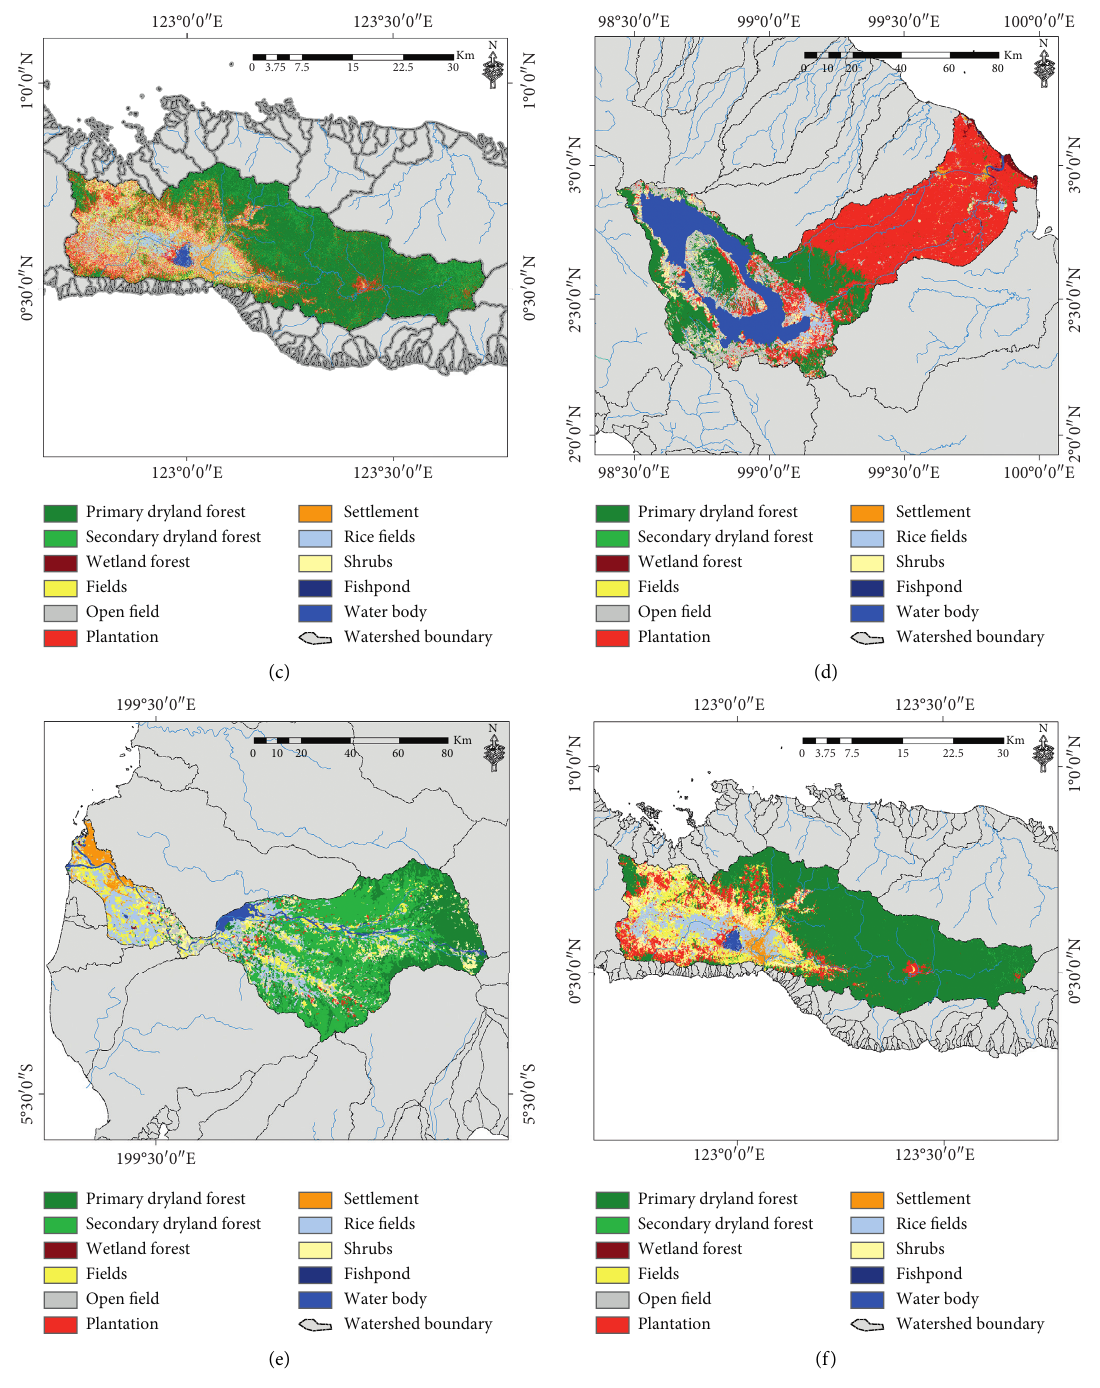
Figure 8: Results of the LULC classification based on the RF classifier: (a, d) Asahan Toba watershed; (b, e) Jeneberang watershed; (c, f) Limboto watershed; process stage without the MaSegFil approach (a–c); process stage with the MaSegFil approach